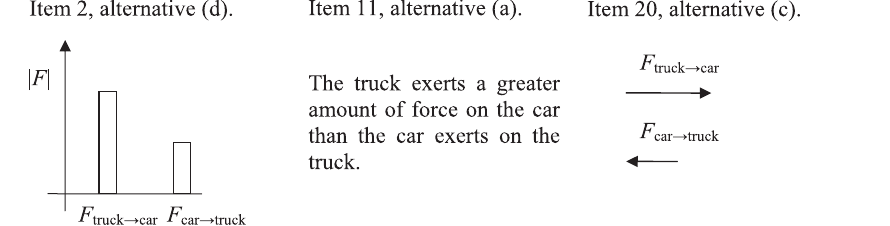
FIG. 2. Corresponding multiple-choice alternatives of a theme. The representational formats of the alternatives are a bar chart (item 2), verbal (item 11), and vectorial (item 20). All three items include an identical, original FCI question in verbal form. The questions with the bar chart and vectorial items include explanations of the notations such as F truck ! car